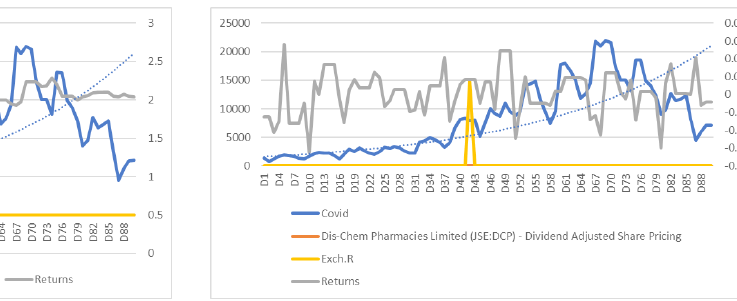
Figure 1. De-Chem Pharmacies Limited Figure 2. Nam Divi Share